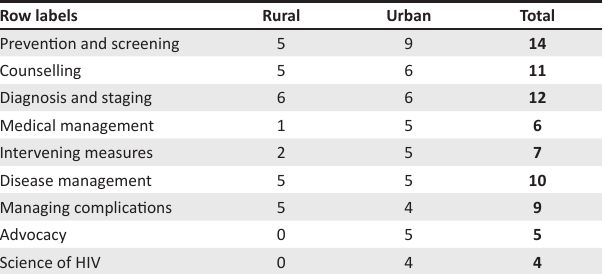
TABLE 5: Distribution of intervention programmes’ activities around